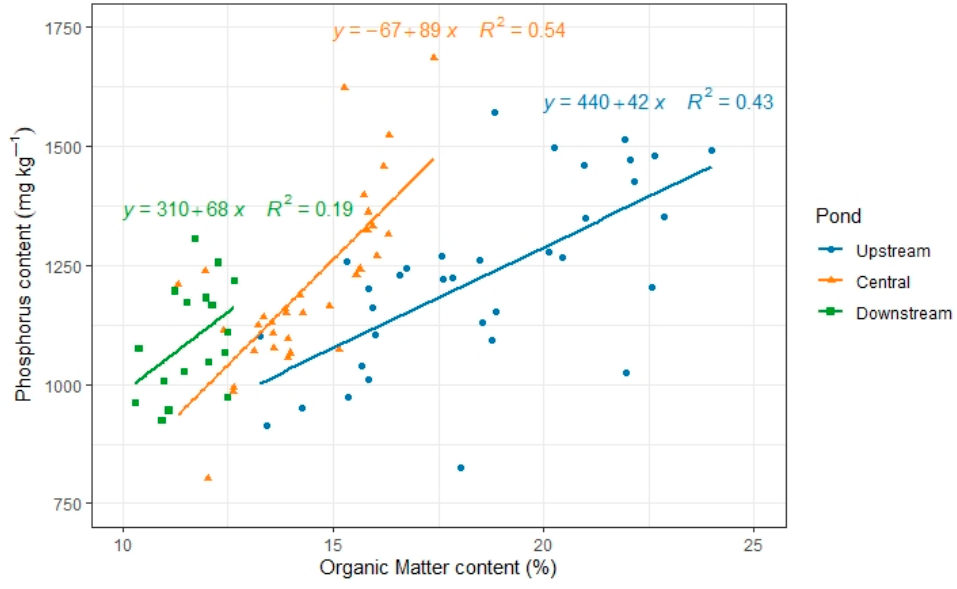
Figure 6. Linear regressions of organic matter content (%) and P content (mg kg − 1 ) of deposited